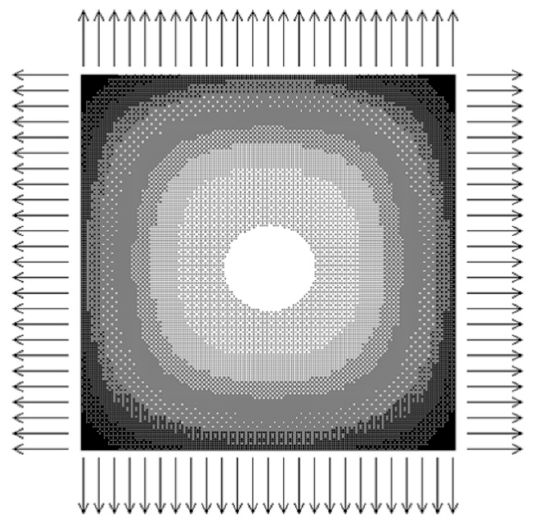
Figure 1. A typical temperature profile in the cross section of a steel billet [23].